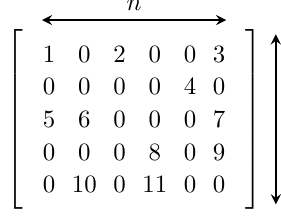
Figure 1. The dense representation of matrix A .